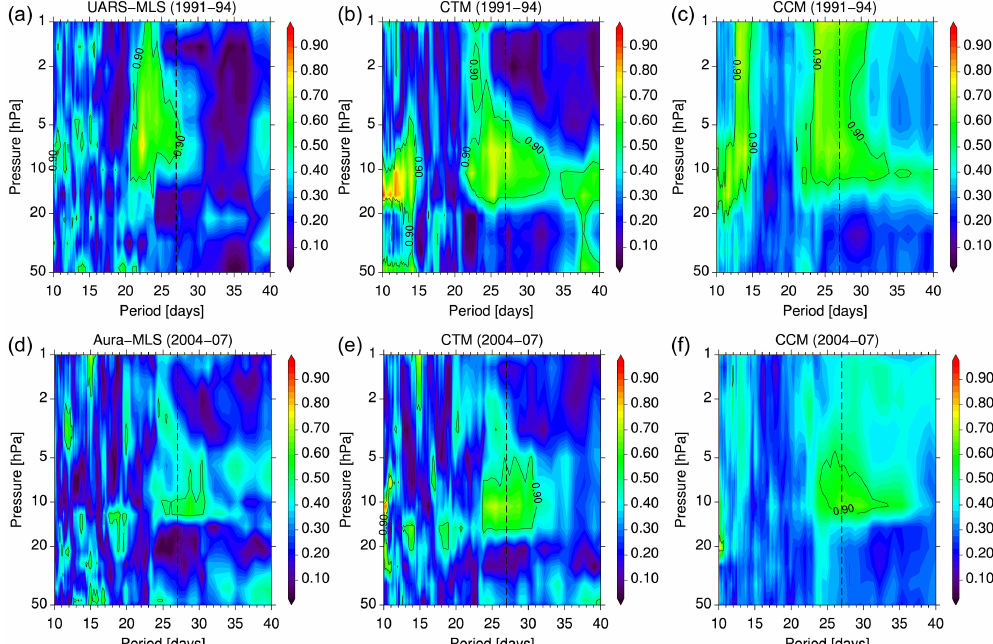
Figure 4. Mean squared coherence between ozone and F205 as a function of period (days) and pressure level (hPa) for the (a, b, c) 1991– 1994 and (d, e, f) 2004–2007 period and for (a, d) MLS observations as well as (b, e) CTM and (c, f) CCM simulations. Black contour lines indicate the 90% confidence level and the vertical dashed black lines indicate the 27-day period.